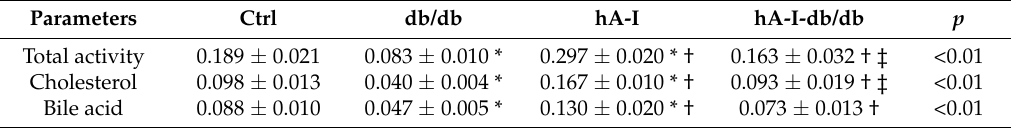
Table 4. Fecal distribution of the [ 3 H]-tracer in the cholesterol and bile-acid fractions in an m-RCT setting.